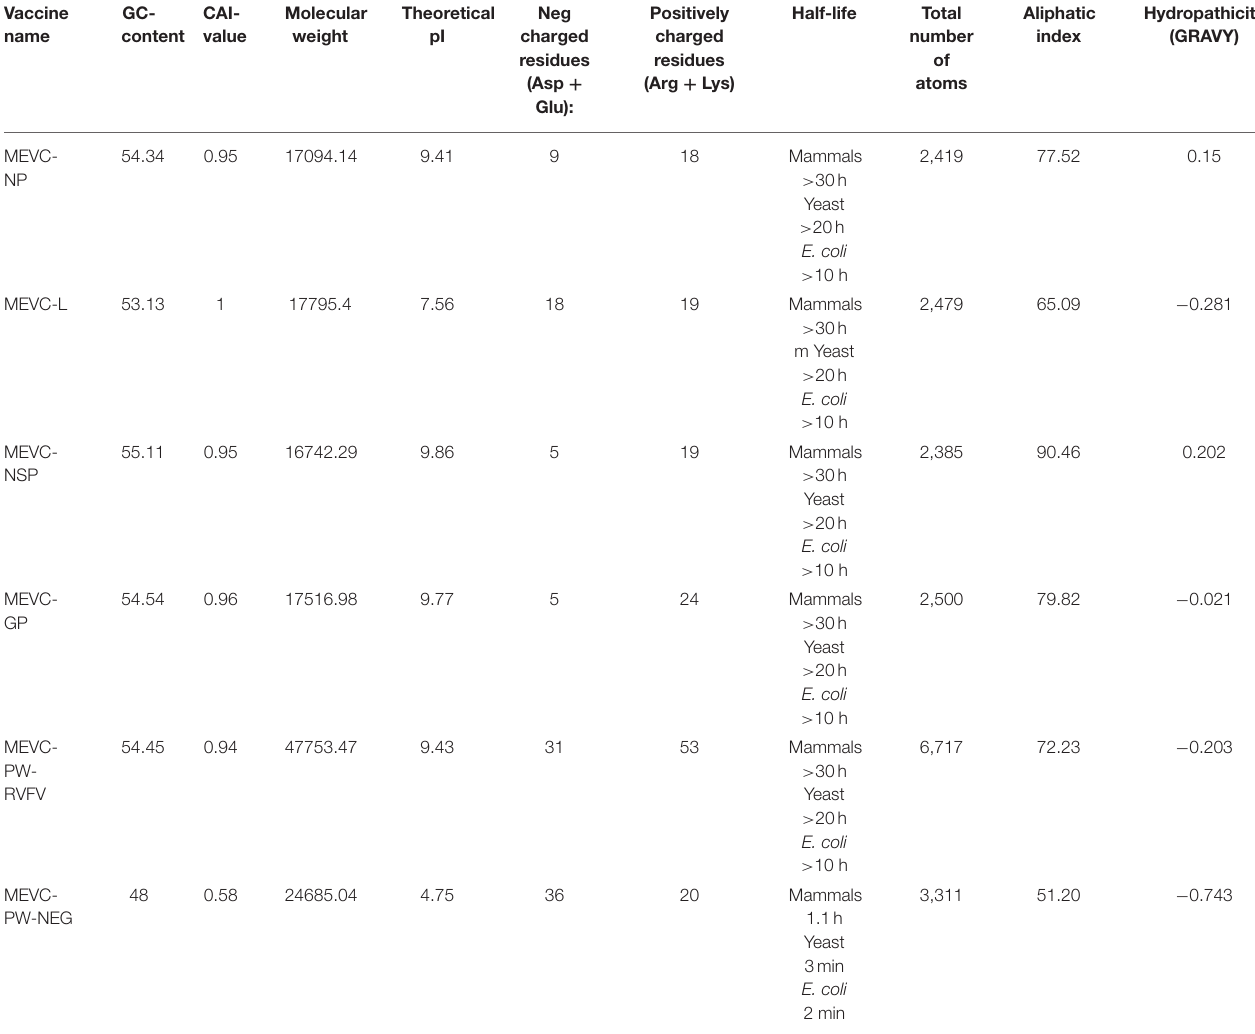
TABLE 7 | Details of the physicochemical information associated with each of the final vaccine constructs against RVFV. Vaccine